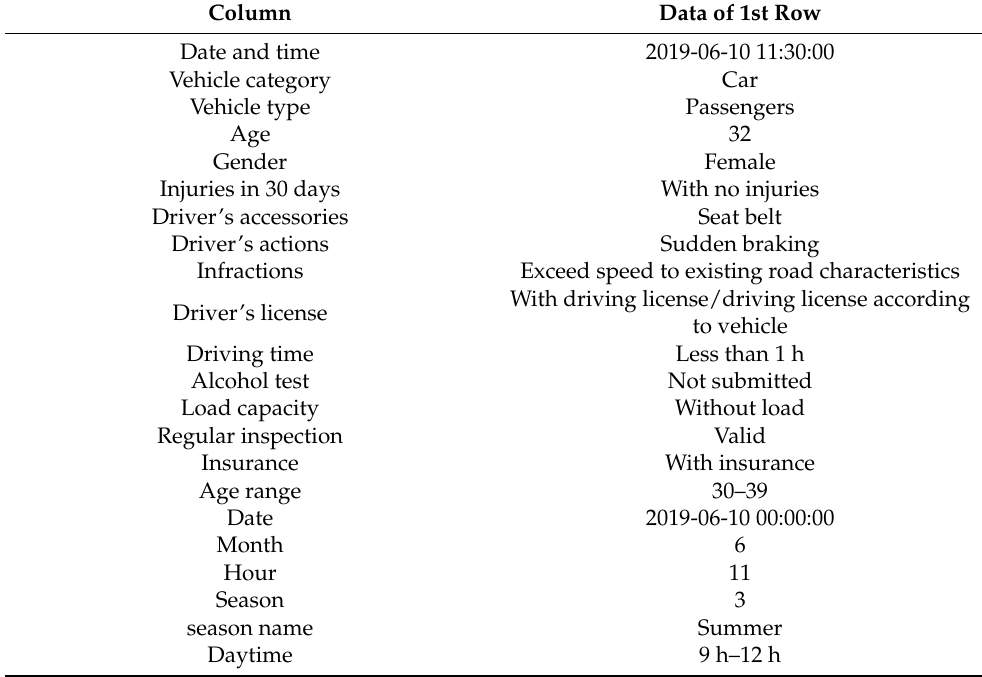
Table 11. Vehicles involved data schema after data preparation.